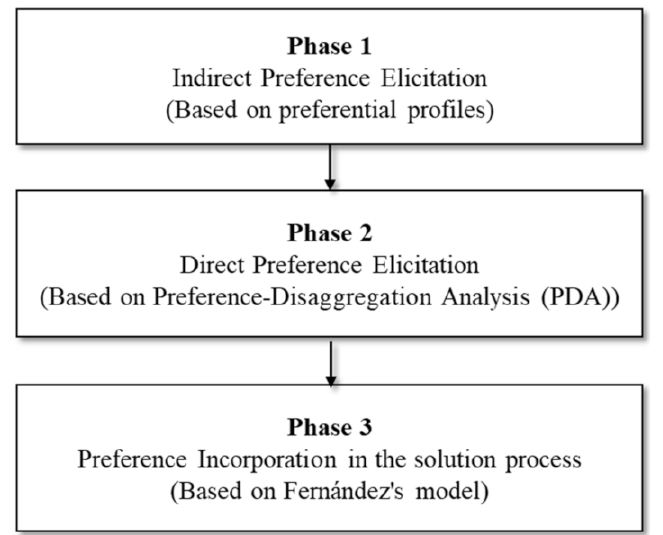
Figure 1. Phases of incorporating preferences in the optimization